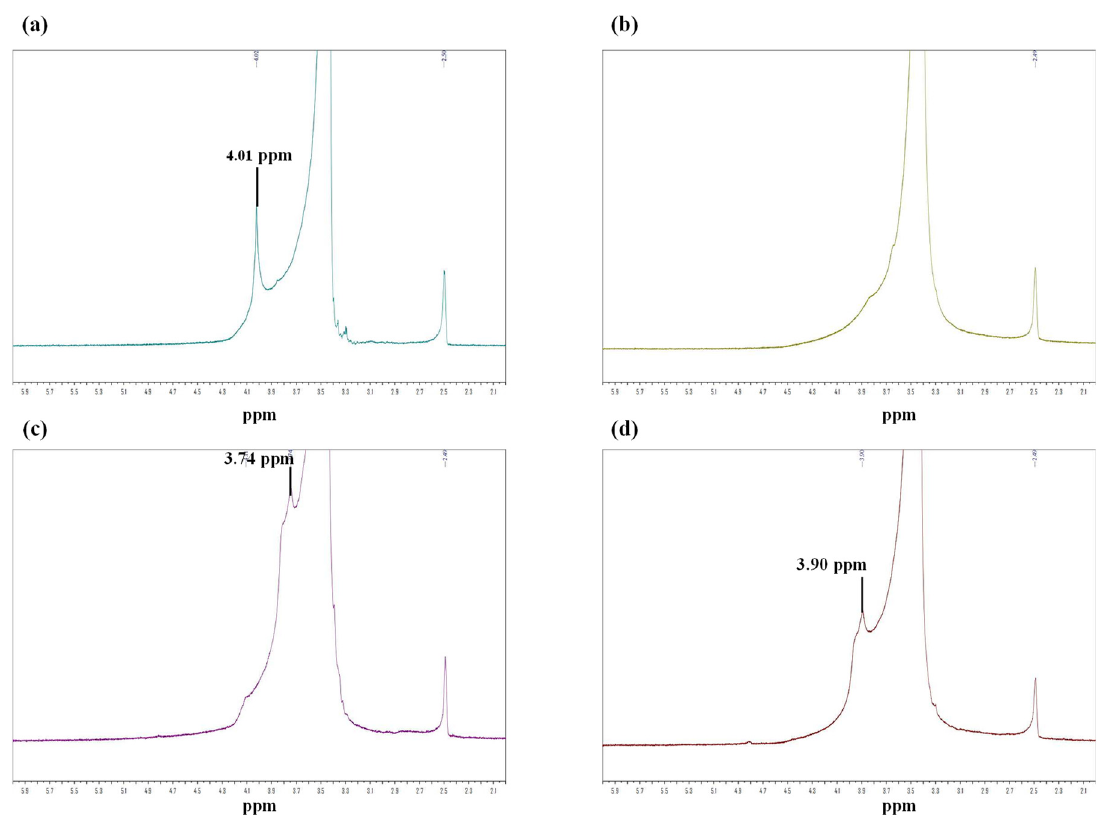
Figure 8. Nuclear magnetic resonance spectroscopy ( 1 H NMR) of ( a ) PEDOT: PSS, ( b ) PEDOT: PSS-sorbitol, ( c ) PEDOT: PSS-sorbitol-maltitol, ( d ) PEDOT: PSS-maltitol.